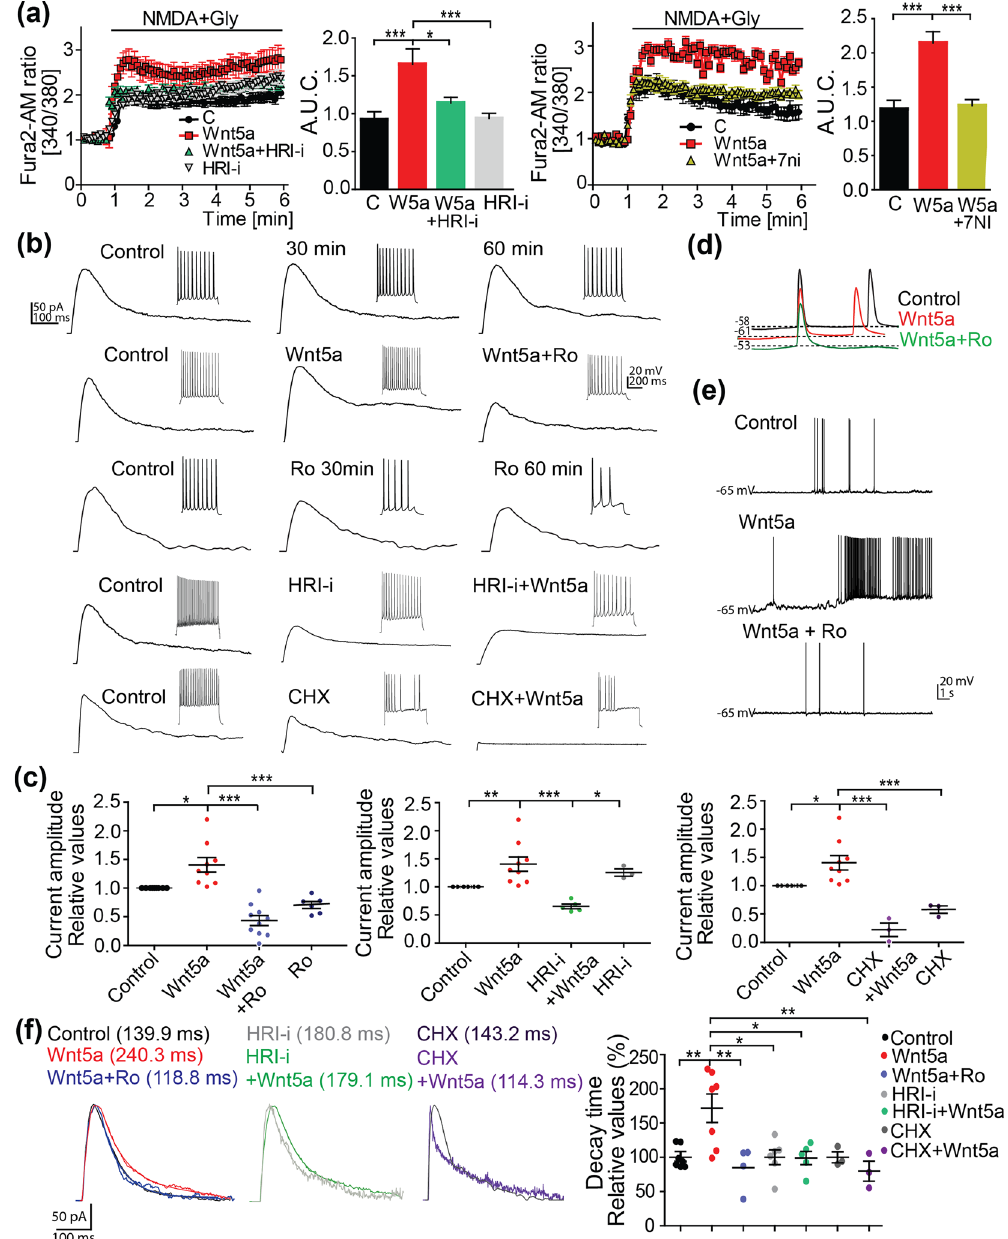
Figure 6. Wnt5a increases the GluN2B-containing NMDAR activity. ( a ) Plots show the normalized Fura-2 AM fluorescence ratio (340/380) over time before and after NMDA + glycine exposure in neurons treated for 1 h with control (C) or Wnt5a (W5a) medium in the presence or absence of HRI-i and 7-NI. Graphs show the AUC of the represented plots. Bars show the mean ± SEM. N = 6 independent experiments. Control (100); Wnt5a (110); Wnt5a+HRI-I (111); HRI-i (109); Control (32); Wnt5a (42); Wnt5a+7-NI (111) number of cells (* p 0.05, *** p = 0.00009). ( b ) Averaged sample traces of NMDAR-EPSCs obtained from the soma of CA1 pyramidal cells voltage-clamped at + 40 mV. Top panel, control currents at 30 and 60 min to show the stability of recordings; second, the current after Wnt5a bath application (1 h) and the selective GluN2B antagonist Ro25-6981 (3 µM); third panel, current after preincubation with HRI-i (1 µM) and Wnt5a addition; fourth, current after preincubation with CHX (50 µM) and Wnt5a. ( c ) The dot plots show the NMDA current amplitudes measured during every treatment relative to the control current in the cell before Wnt5a or drug application. The relative values for each condition were averaged and plotted as shown (Control, Wnt5a: N = 9 cells from 5 mice; Wnt5a + Ro: N = 10 cells from 5 mice; Ro: 6 cells from 5 mice; Wnt5a + HRI-i: N = 5 cells from 5 mice; HRI-i: N = 3 cells from 3 mice; Wnt5a+CHX: N = 3 from 3 mice; CHX: N = 3 from 3 mice). Lines represent the mean ± SEM; (* p 0.05, ** p < 0.001, *** p = 0.00009). ( d , e ) Spontaneous action potentials (APs) in current clamp configuration. The presence of Wnt5a reduces the firing threshold for AP generation ( d ), and at the same resting membrane potential, Wnt5a induces more APs and also the generation of regular periods of bursts of activity ( e ). Notably, the presence of Ro prevented this feature. ( f ) The recordings obtained in ( b ) were normalized to obtain decay kinetics (tau, ms) in every tested condition. The dot plots show the relative values of the decay measurements and the mean ± SEM (* p < 0.05; **: p <